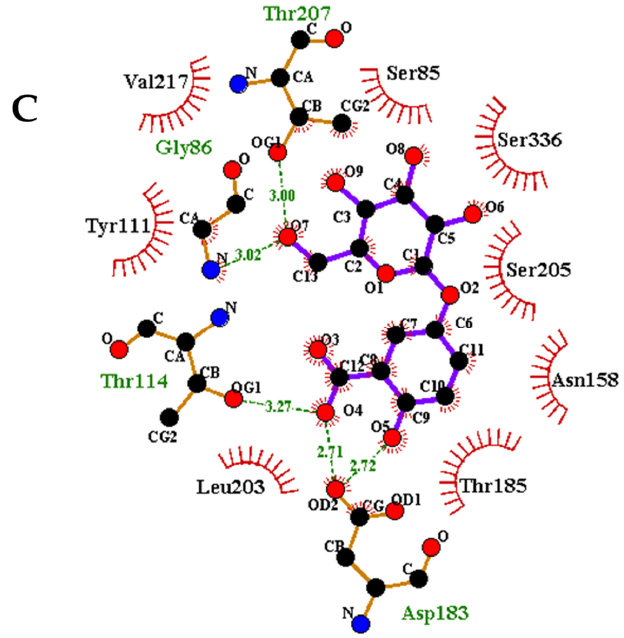
Figure 9. Protein-ligand interactions elucidated with LigPlot+. Shikimic acid-4-O-gallate ( A ), Epitaxifolin ( B ), and Gentisic acid 5-O-glucoside ( C ) represented by blue sticks. Carbon atoms are signified as black dots and red dots show oxygen atoms. Hydrophobic contact residues with the ligands are shown as semi-circles with “spokes”. Hydrogen bond interaction patterns are represented as green dash lines.